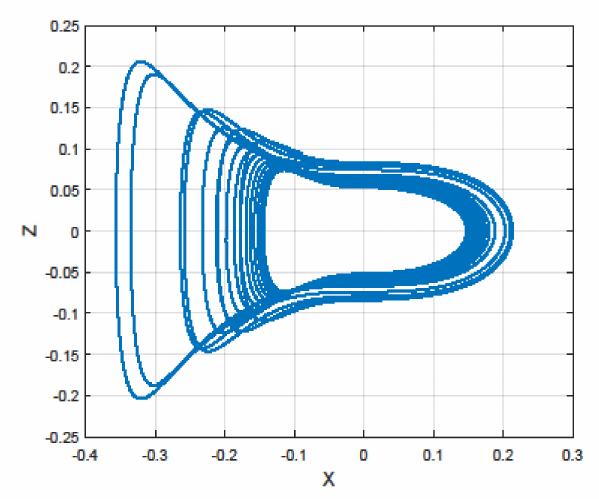
Figure 13. The 2-D signal plot of the discrete-time chaotic system (9) using Forward Euler finite- difference scheme in the ( x , z )